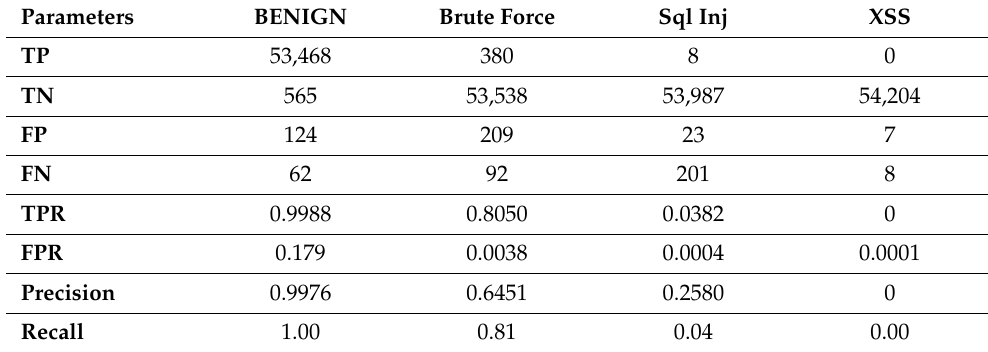
Table 6. Statistical report of Thursday morning test dataset.